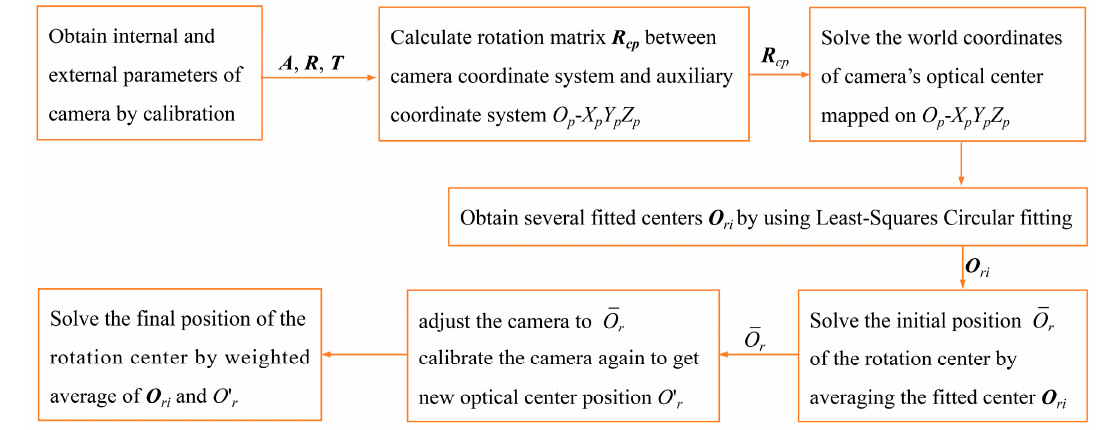
Figure 3. The flow chart of the Figure 3. The fl ow chart of the procedure.